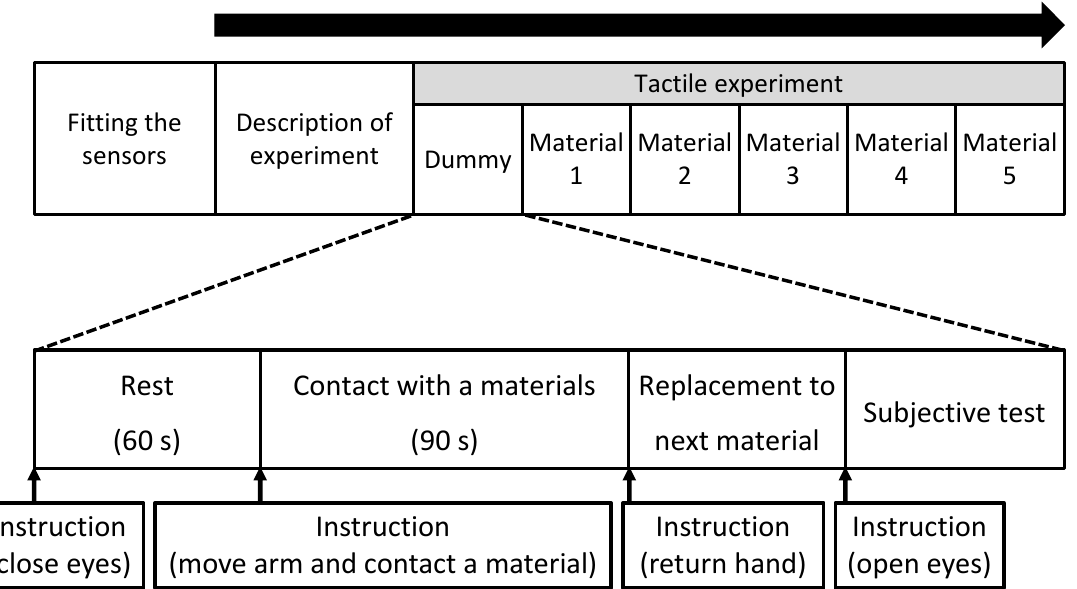
Figure 2. Experimental schedule.